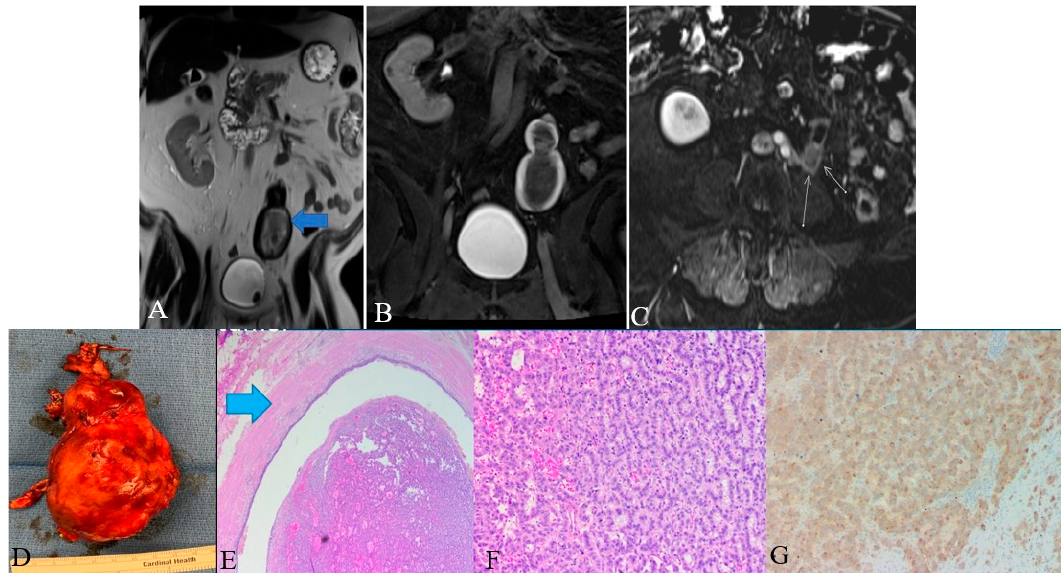
Figure 13. A 48-year-old female with ureteral NEN. ( A ) Coronal T2 nonfat sat image shows a large expansible hematoma in the ureteric stump (arrows). ( B ) Coronal T1 postcontrast delayed fat sat image: Shows a large expansible hematoma with intrinsic high T1 signal. ( C ) Axial T1 postcontrast delayed fat sat subtraction image: a small enhancing nodule (arrows) along the superior aspect of the stump. ( D ) Left lower ureter mass consists of a segment of the ureter with an attached firm, tan-brown, irregular, mass, measuring 11.5 × 7.0 × 6.0 cm. ( E ) E&H staining: 20 × shows polypoid tumor bulging into the ureter lumen. Normal urothelial mucosa and muscle layer can be seen on the top half (arrow). ( F ) H&E straining: 200 × high-power view shows tumor cells arranged in a trabecular and tubular pattern. ( G ) Synaptophysin staining: 200 × shows tumor cells expressing synaptophysin (brown staining), which is a marker of neuroendocrine differentiation. Table 7. Morphological features of small-cell ureteral NEC.